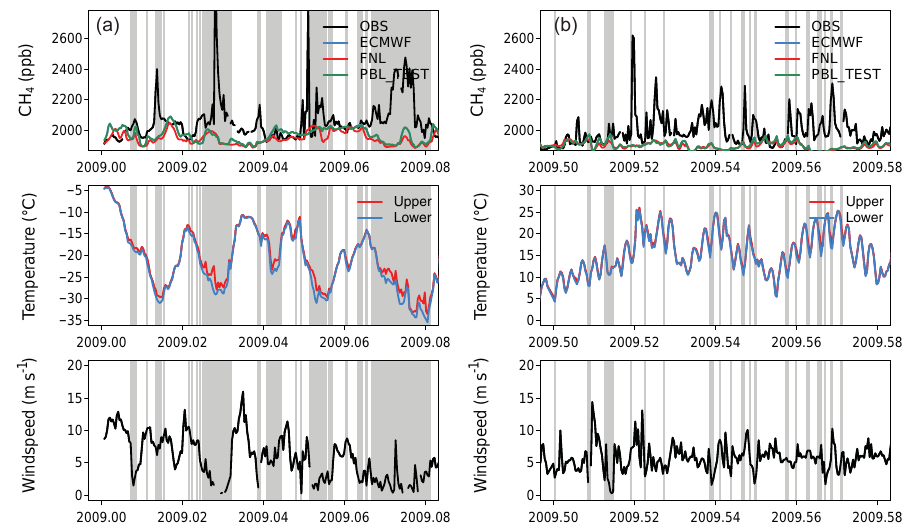
Figure 5. Example of measurements of CH 4 , temperature at two heights on the tower, and wind speed, at IGR in January 2009 (a) and July 2009 (b) . Also shown in the upper plots, are CH 4 concentrations simulated with prior fluxes using FLEXPART driven with ECMWF EI (blue) and NCEP FNL (red) meteorological analyses and a sensitivity test using ECMWF EI but with no minimum PBL height set in FLEXPART (green) (note that this is on top of the blue line). The vertical shading indicates periods when data were filtered